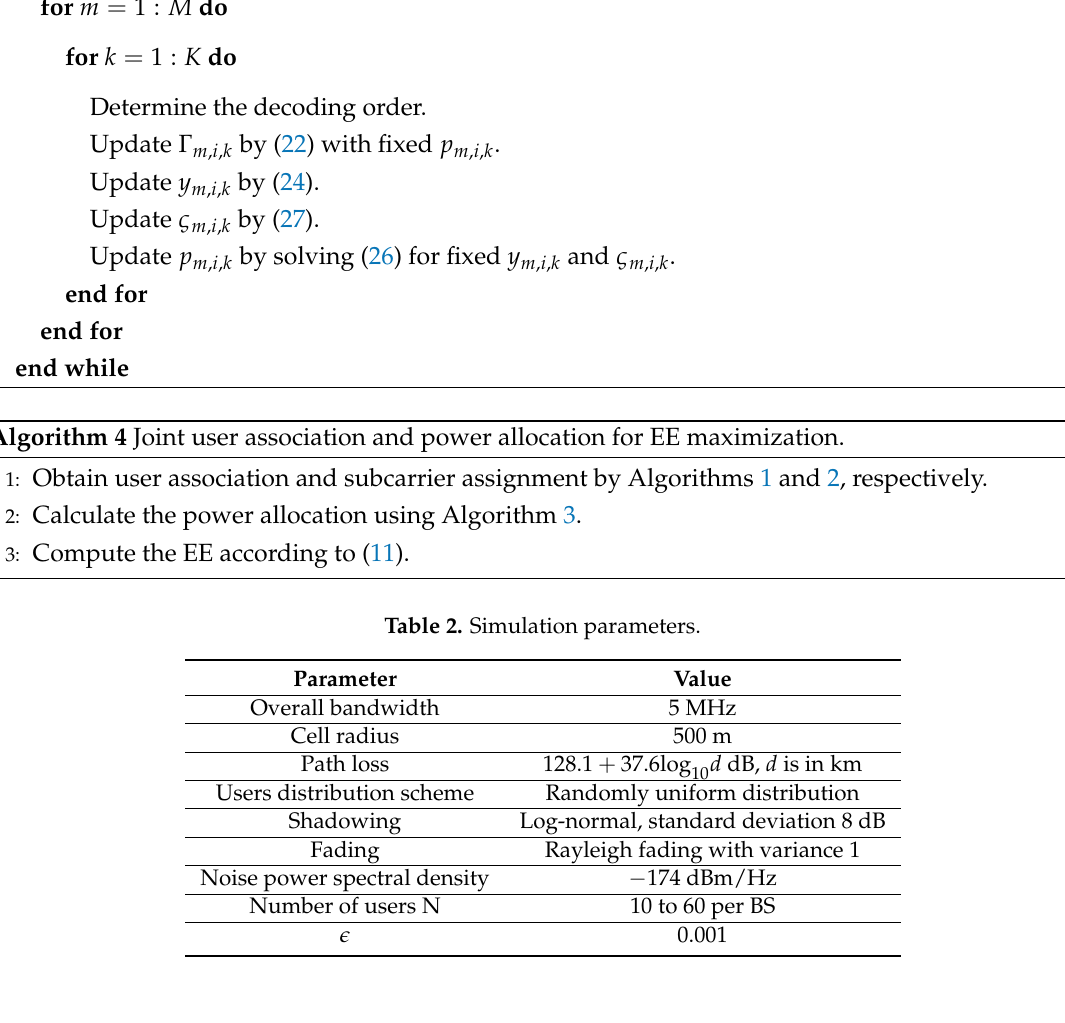
Algorithm 3 is achieved in iterations O Algorithm 3 Power allocation for EE maximization.